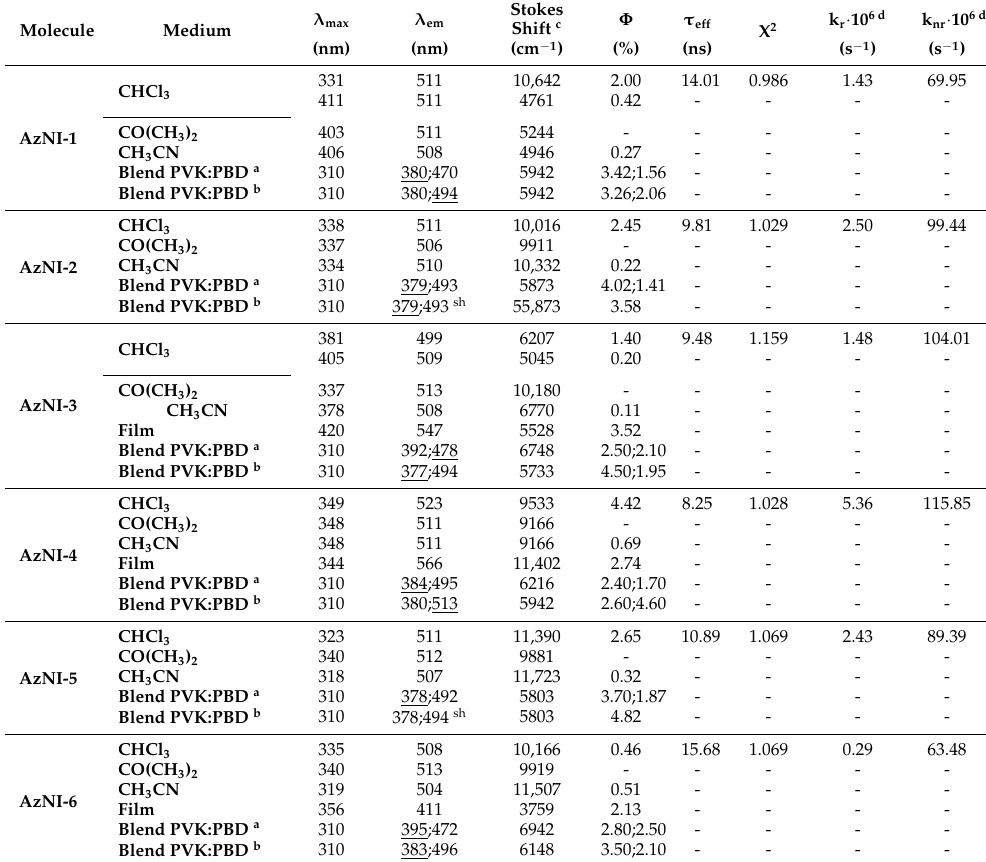
Table 4. PL data of the synthesized